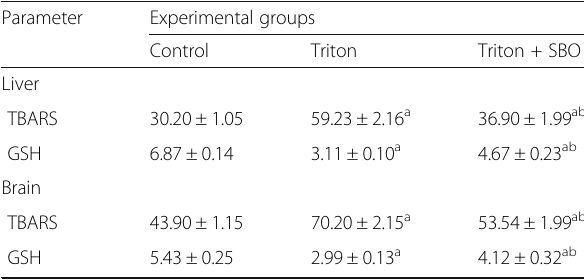
Table 2 The effect of soybean oil (SBO), Triton WR-1339, and their combination on the liver and brain content of TBARS and GSH in male rats compared to a control group